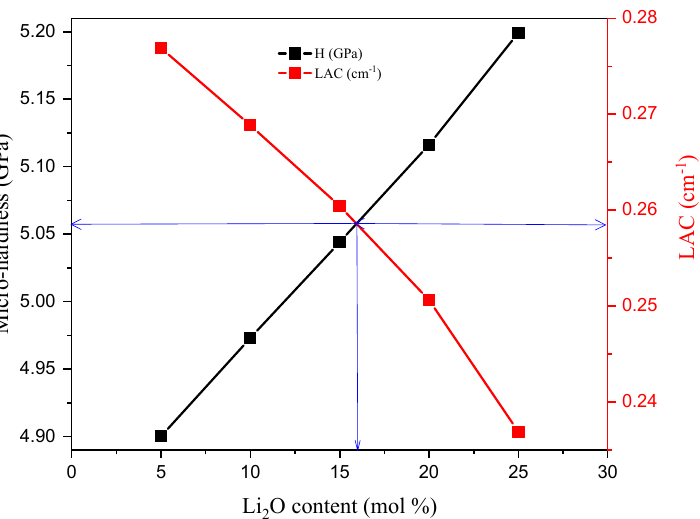
Figure 19. Relationship between the microhardness and the linear attenuation coefficient (LAC) for the various investigated samples.